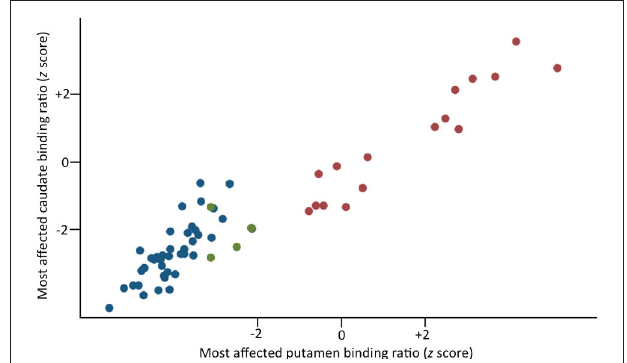
FIGURE 1 | Scatterplot of the binding values ( z scores) for the most affected putamen and caudate in PD patients (blue circles) and BD patients with (green circles) and without (red circles) dopaminergic